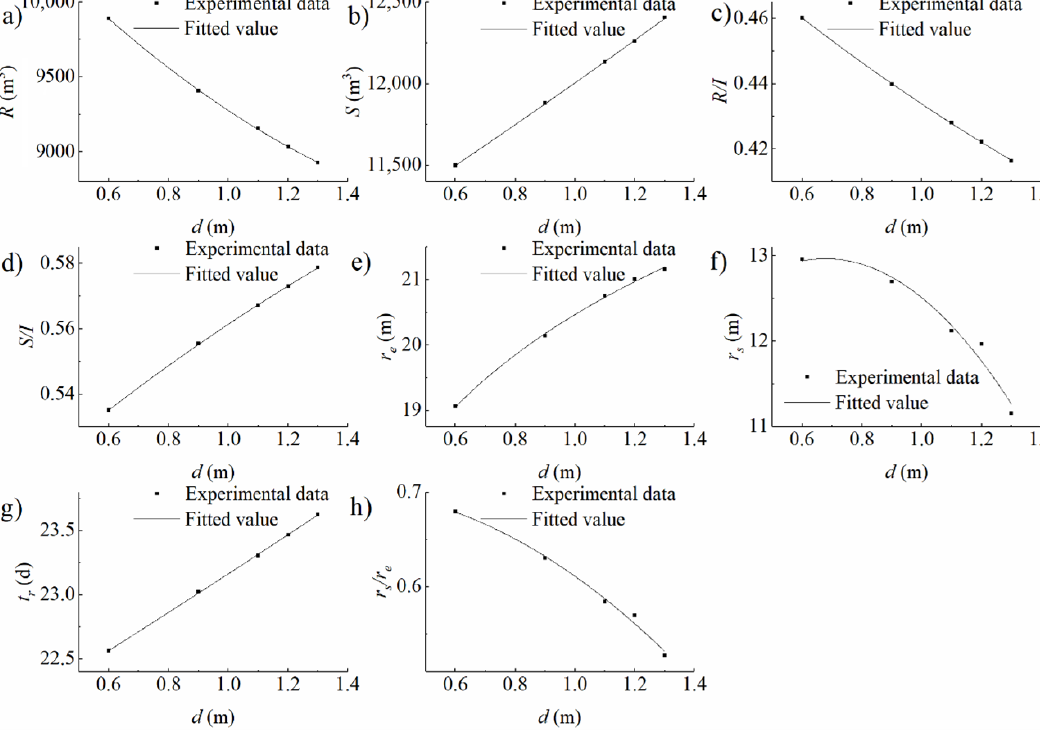
Figure 17. The variations with an increment in d when the depth is 55 m. (( a ) variation of R; ( b ) variation of S; ( c ) variation of R/I; ( d ) variation of S/I; ( e ) variation of r e ; ( f ) variation of r s ; ( g ) variation of t r ; ( h ) variation of r s /r e .).